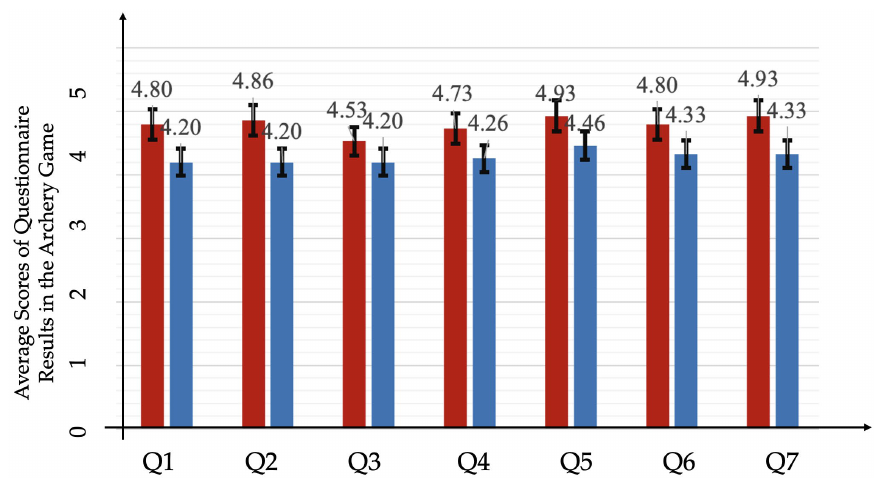
Figure 11. Questionnaire results in the archery game. Our proposed method and IK.